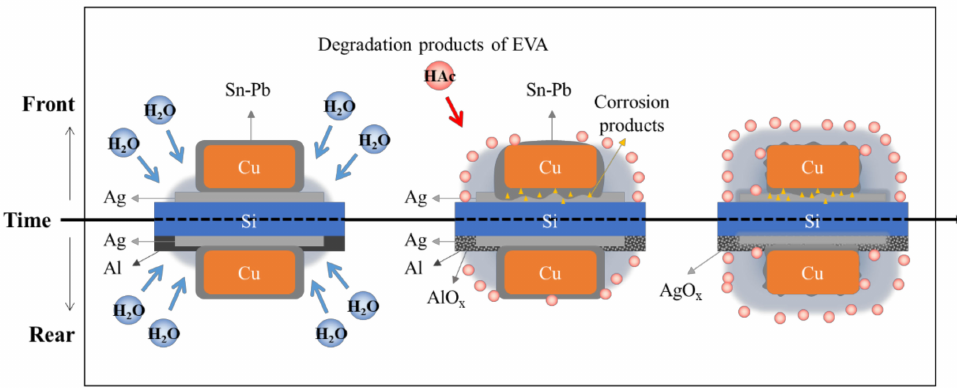
Figure 6. Corrosion steps at the front and rear sides of a solar cell. The color change may occur in a different area, rather than next to the PV module. This may mean that the discoloration originates from the polymer of the encapsulation, such as EVA. Moreover, the EVA fails to disseminate in the same method in all cell parts in the same manner [53]. The discolored photovoltaic cells are shown in Figure 7.